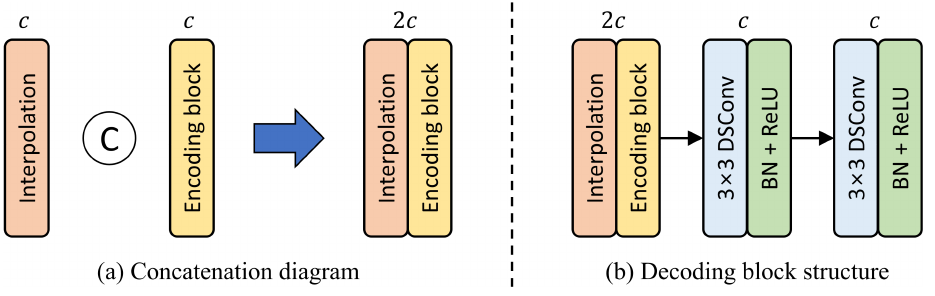
Figure 7. Decoder